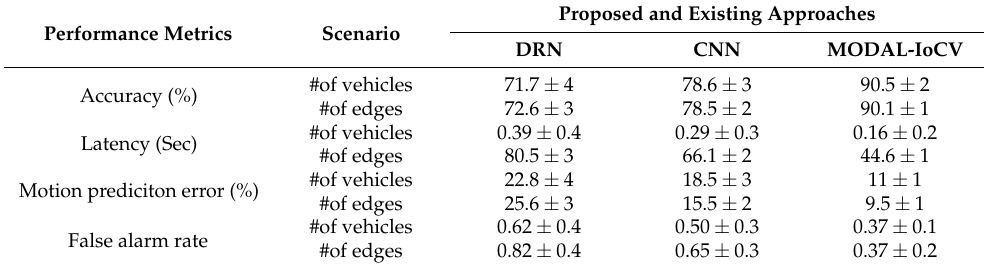
Table 7. Performance